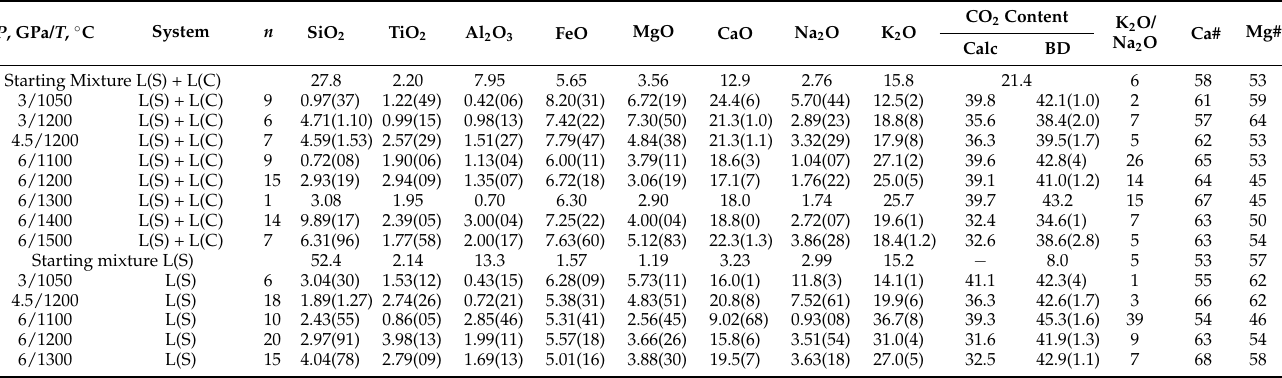
Table 6. Compositions (wt%) of carbonate